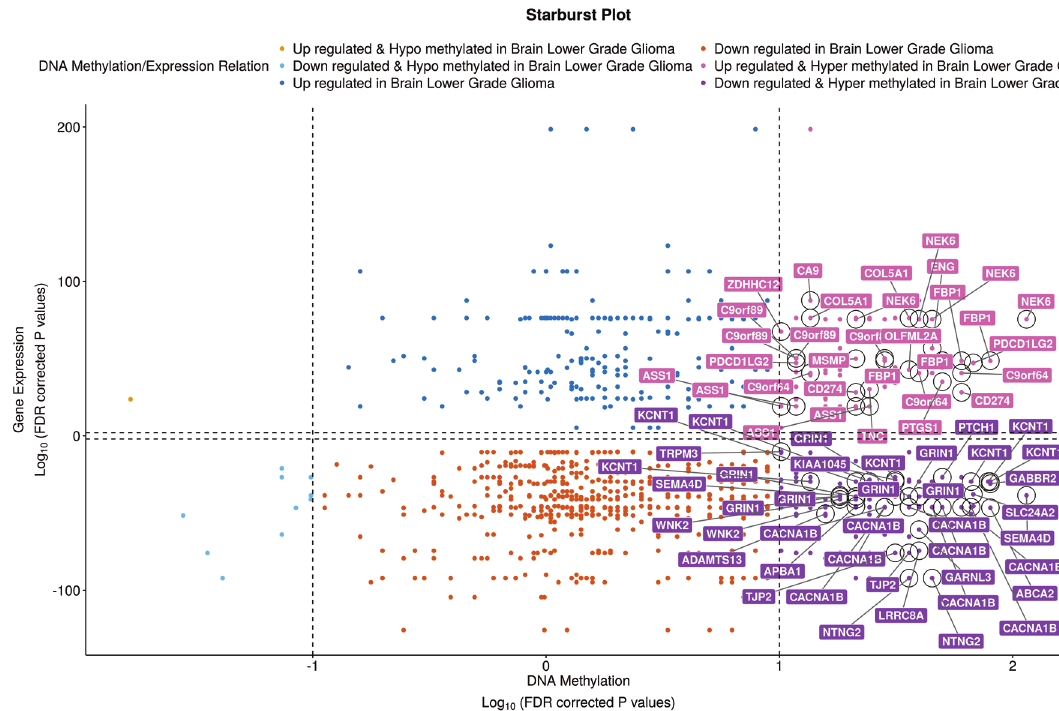
Figure 13. Starburst plot: x-axis is the log10 of the correct P-value for DNA methylation and the y-axis is the log10 of the correct P-value for the expression data. The starburst plot highlights nine distinct quadrants. Highlighted genes might have the potential for activation due to epigenetic